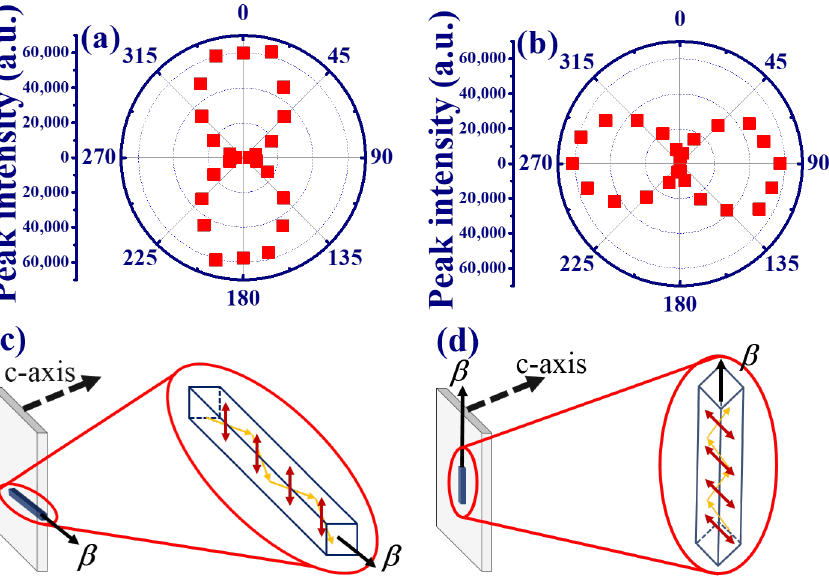
Figure 5. Polar plots of peak intensities from the surface normal of the MQWs by the ( a ) TE mode pump polarization, and ( b ) the TM mode pump polarization after the rotation of a cylindrical lens by 90 degrees. Illustration of the light propagation and direction of the electric field of SE by the ( c ) horizontal and ( d ) vertical pump stripe line on the